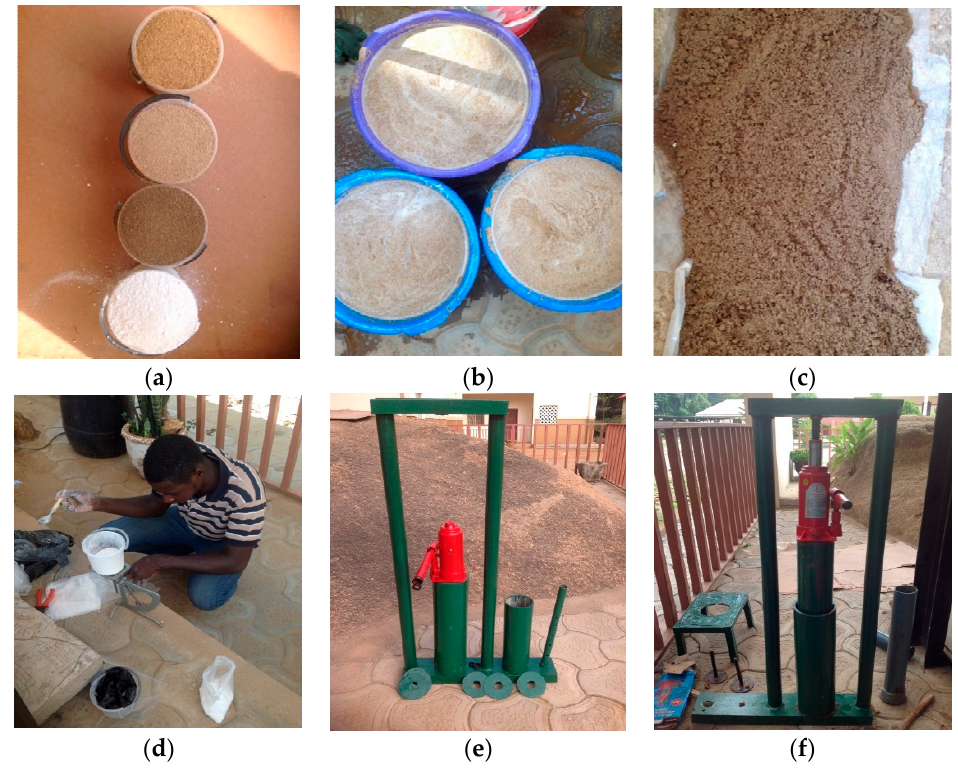
Figure 1. Materials used for the production of the briquette and production process. ( a ) Particle types and starch; ( b ) Pre-treatment in hot water (100 °C); ( c ) Drying of the particles; ( d ) Weighing of the materials (particle and starch); ( e ) Fabricated briquette hydraulic moulder; ( f ) Compression, hydraulic pressing, and moulding of the briquette.